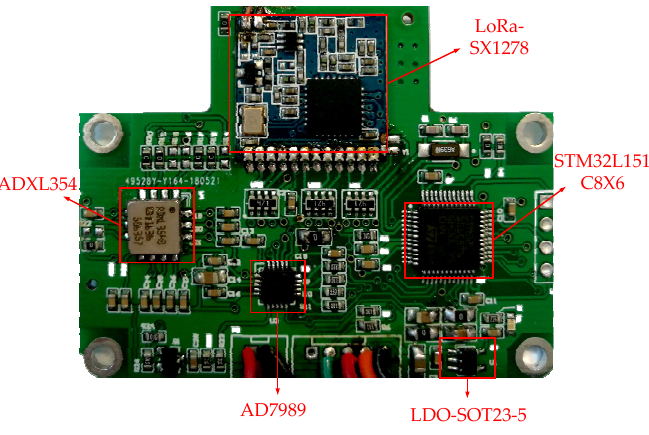
Figure 8. Circuit board of acceleration sensor.